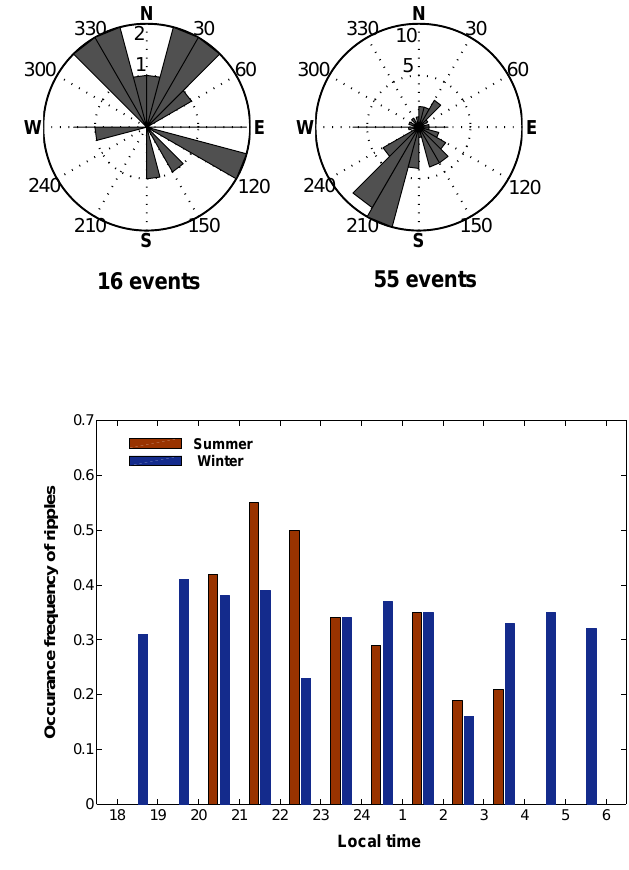
Fig. 9. Local time dependence of ripple occurrence frequency in summer and